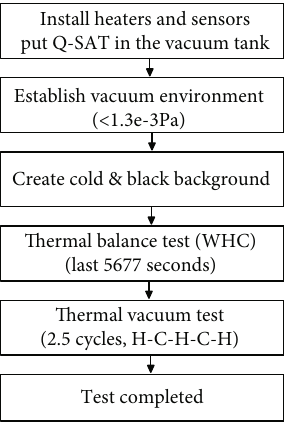
Figure 11: Steps of thermal test (H: hot; C: